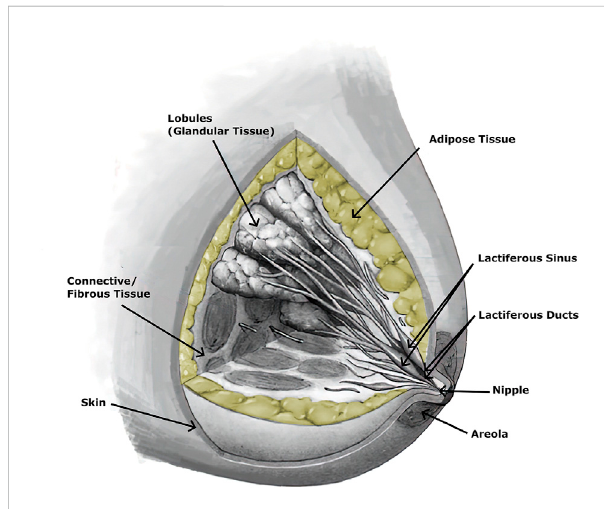
FIGURE 2 Anatomy of the breast, with adipose tissue colored